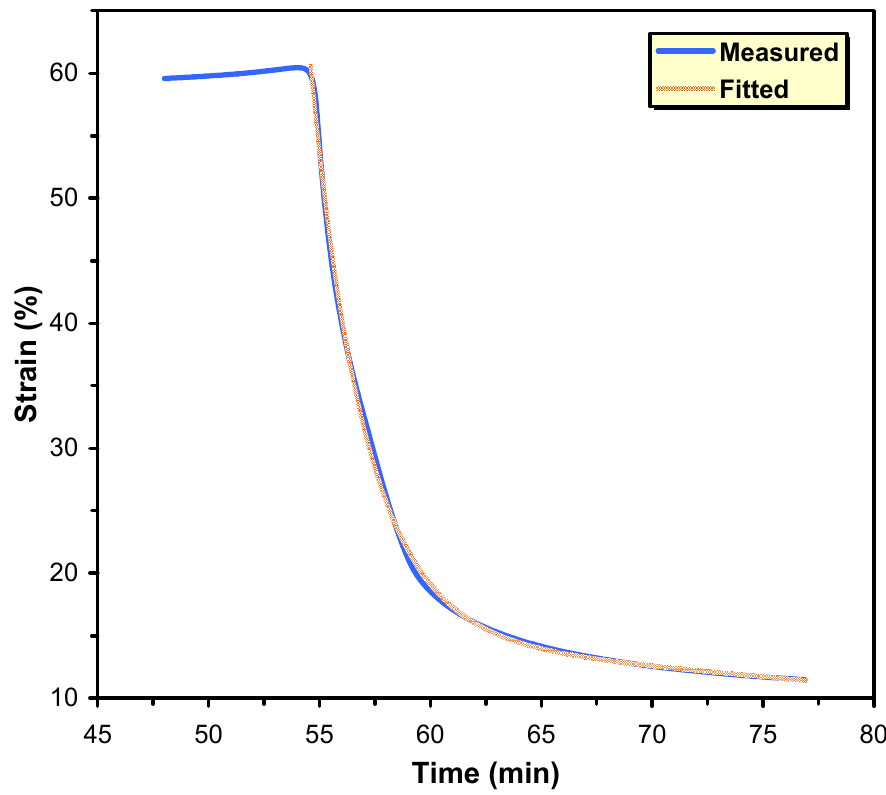
Figure 9. Variation of the strain with time for the shape recovery of PU 4. Initial strain: 60%. The reddish solid line shows the fitted curve using Equation (9). The fitted parameters are A f = 41.4%, A s = 15.3%, τ f = 2.4 min and τ s = 76.3 min. Fitting was started at t 0 = 54.6 min.